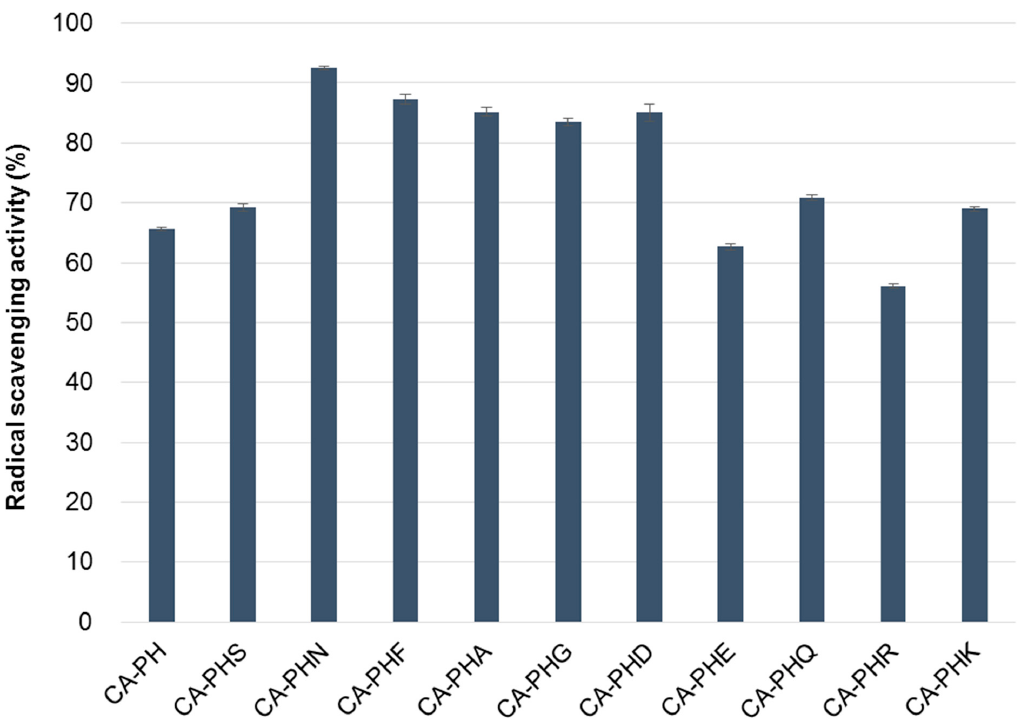
Figure 2. DPPH radical scavenging activity of the CA-PHX-NH 2 derivatives. Each experiment was performed in triplicate. Results are presented as mean ± standard error.